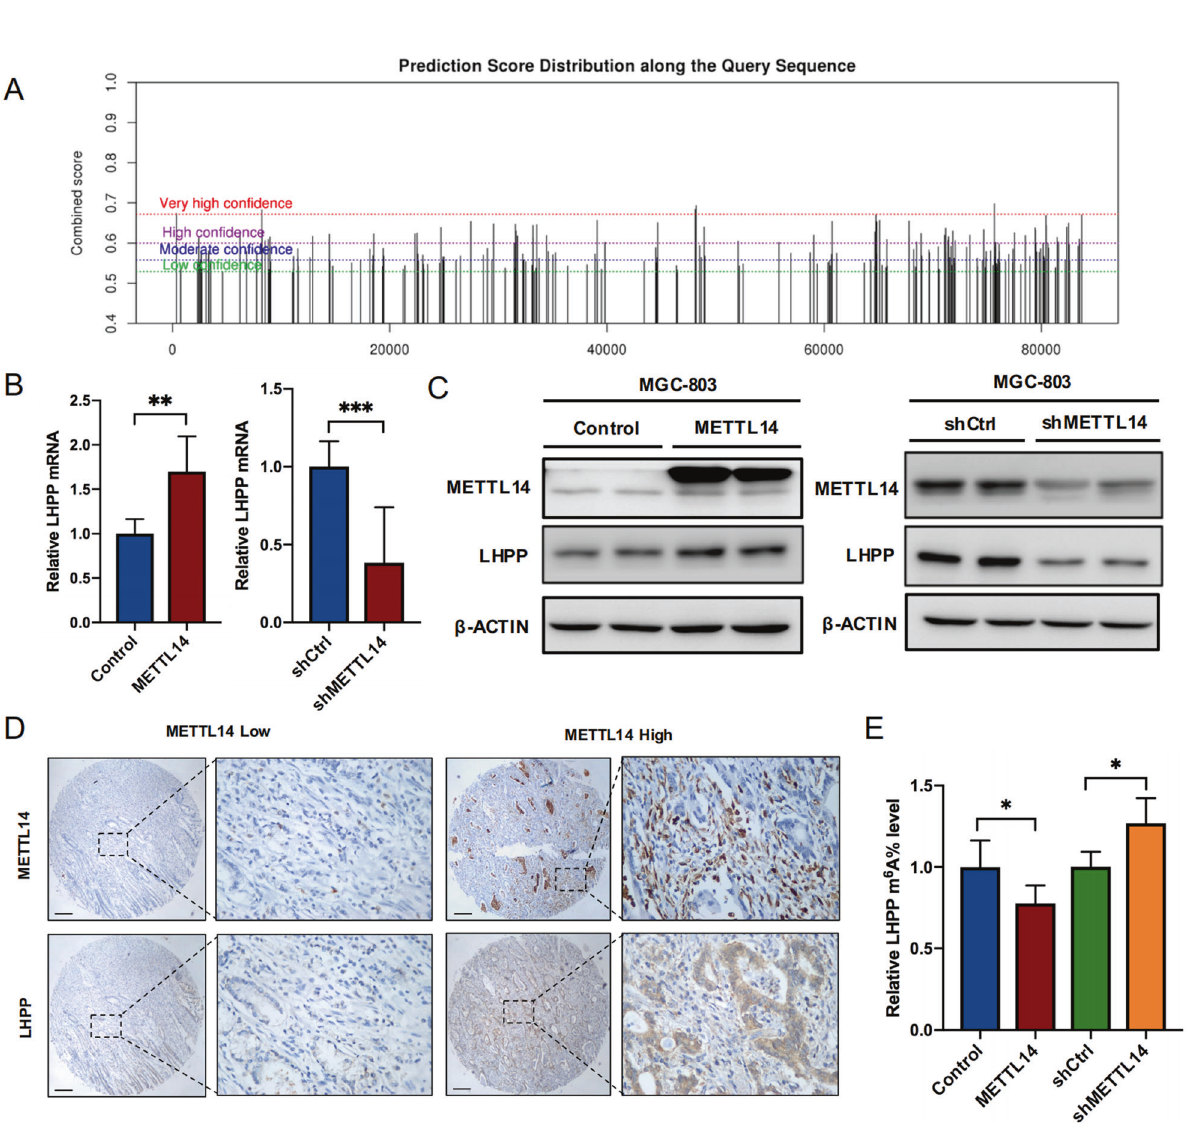
Fig. 4 METTL14-mediated m6A modi fi cation represses LHPP expression in GC. A The potential m6A sites were predicted by SRAMP. B , C qRT-PCR and western blot assays revealed the mRNA and protein expression, respectively, of LHPP in GC cells with knockdown or overexpression of METTL14. D IHC staining of LHPP and METTL14 in TMAs. Scale bars = 200 μ m. E m6A immunoprecipitation and qRT-PCR assays showed the relative percentage of LHPP mRNA with methylation. Data were analyzed using the Wilcoxon test. * P < 0.05, ** P < 0.01, *** P < 0.001, ns no signi fi cant difference, GC gastric cancer, qRT-PCR quantitative reverse transcription-polymerase chain reaction, IHC immunohistochemical, TMS tissue microarrays.